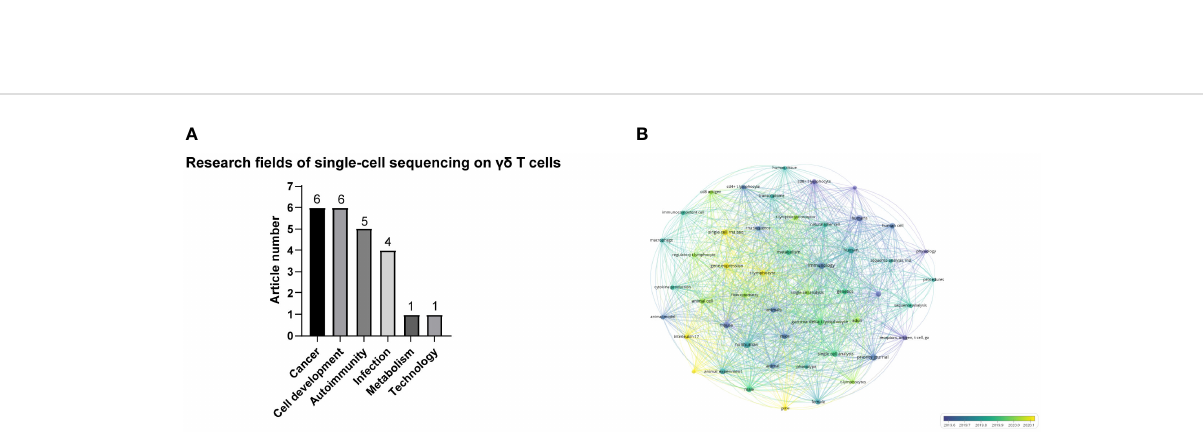
FIGURE 6 (A) Number of articles on different research fi elds involving gd T cells and single-cell sequencing. (B) All Keywords co-occurrence analysis of single-cell sequencing on gd T